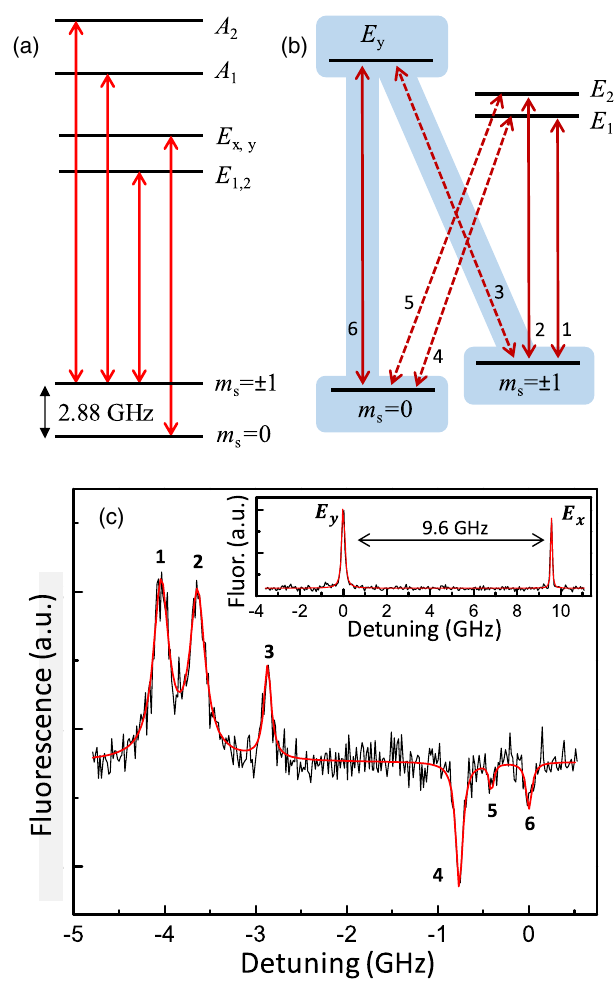
FIG. 3. (a) Energy-level structure and dipole optical transitions of a NV center (strain free). (b) State mixing due to built-in dc strain, leading to additional dipole transitions, as indicated by the dashed lines. Shaded levels and arrows highlight the Λ -type three-level systems used in our experiments. (c) Excitation spectrum with a pump field fixed at the E transition. Peak x labels indicate the corresponding transitions in (b). Red lines are fits to Lorentzians. Inset: Excitation spectrum obtained with no pump